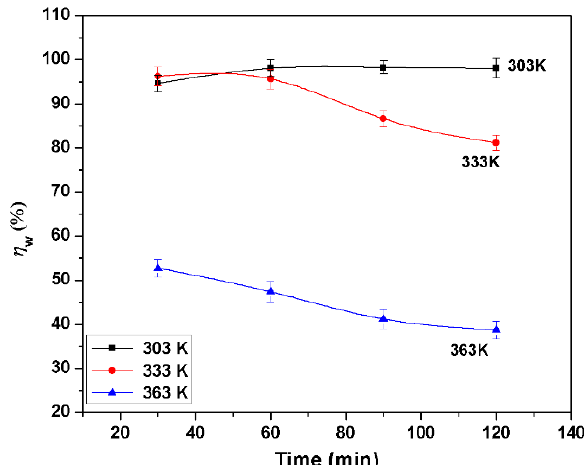
Figure 2. Relationship between inhibition e ffi ciency ( η w ) and time in 1 M HCl at di ff erent temperatures using weight loss method at 3 mM concentration of inhibitor.